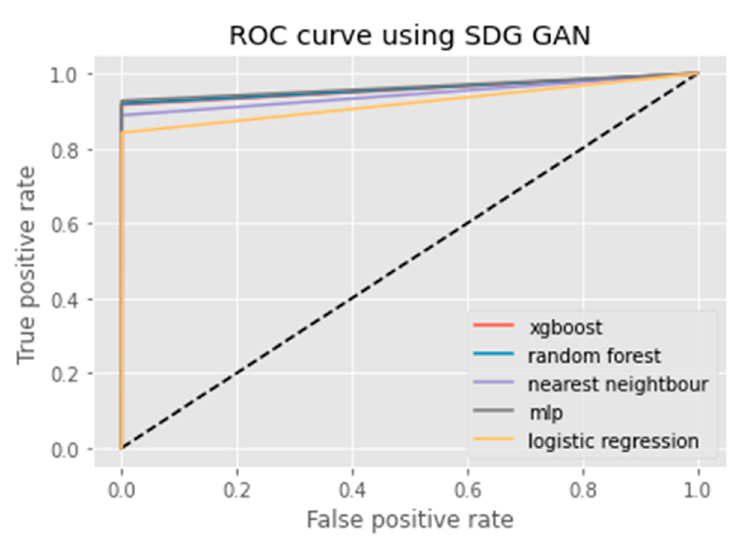
Figure 8. ROC curve using WS GAN.